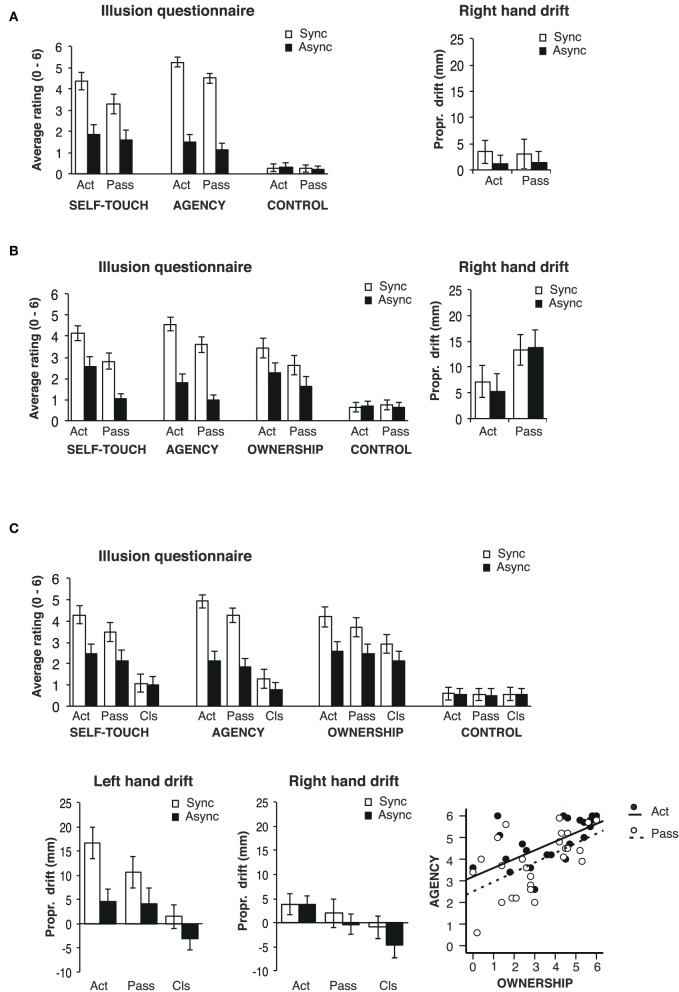
Mean questionnaire ratings and proprioceptive drifts. (A) Mean questionnaire ratings and mean PDs for right hand in Experiment 1. The sense of illusory self-touch was enhanced in synchronous stimulation compared to asynchronous stimulation. Additionally, the participants reported stronger illusion when they actively touched the virtual hand and their own hands with the master-slave system. Neither synchrony nor stimulation type modulated the PD. (B) Mean questionnaire ratings and mean PDs for right hand in Experiment 2. In addition to the sense of illusory self-touch, the participants reported stronger illusory ownership over the virtual left hand with synchronous and active stimulation. Greater PD was found in the passive stimulation conditions. (C) Mean questionnaire ratings, PDs for both left and right hands in Experiment 3, and correlation between the sense of agency and sense of hand ownership for active-synchronous and passive-synchronous conditions. The illusory self-touch was induced in active and passive self-touch, and all the stimulation types allowed the participants to experience the illusory ownership over the virtual left hand. The experience of RHI became stronger in the order of active self-touch, passive self-touch, and classical stimulation. The PDs for right hand did not show any significance, but a greater PD for left hand was observed with synchronous stimulation in active self-touch. In the graphs, Act/Pass/Cls and Sync/Async mean active self-touch/passive self-touch/classical stimulation and synchronous/asynchronous, respectively.